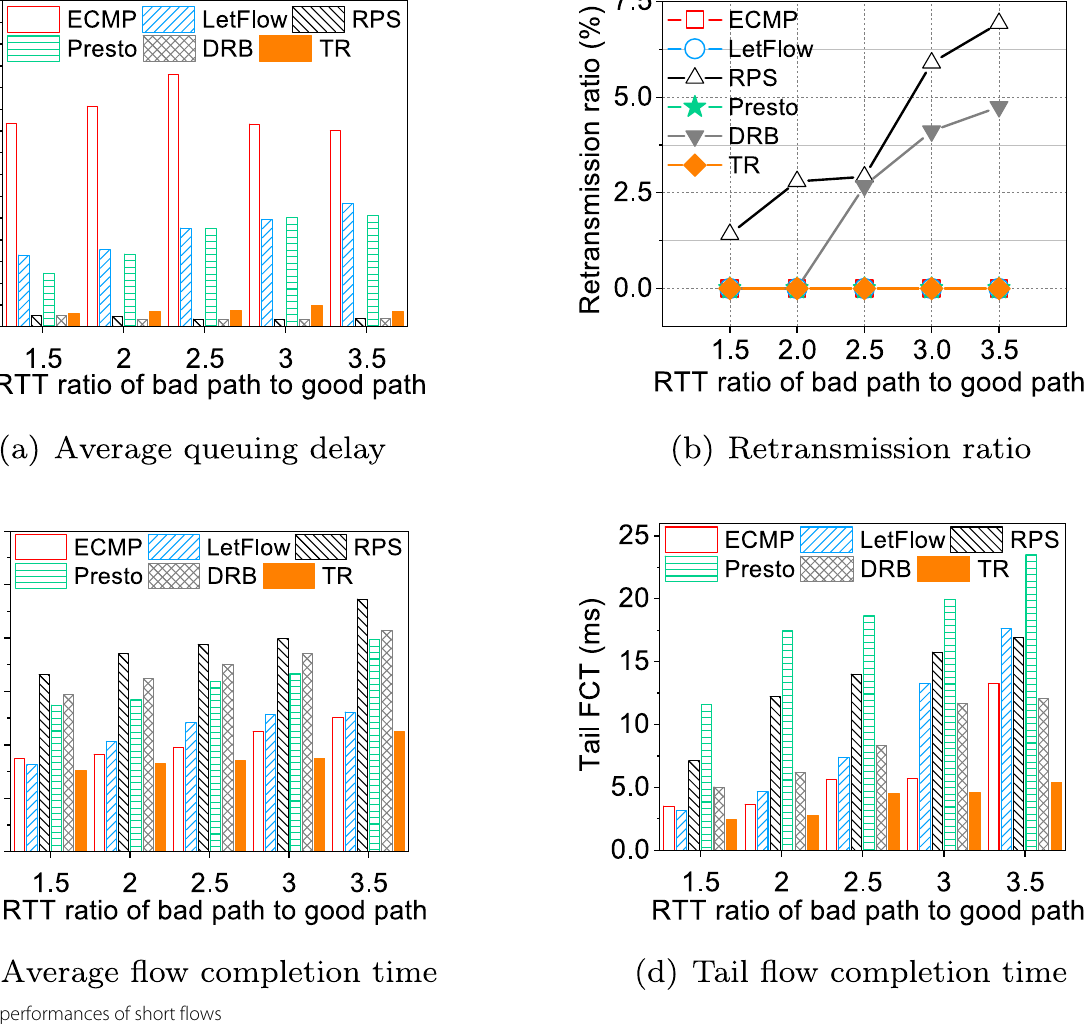
allow long flows to avoid short flows for further speeding up the short flow’s data transfer, thus always obtaining the shortest average and tail flow completion times compared to the other schemes across all cases, as shown in Fig. 7(c) and